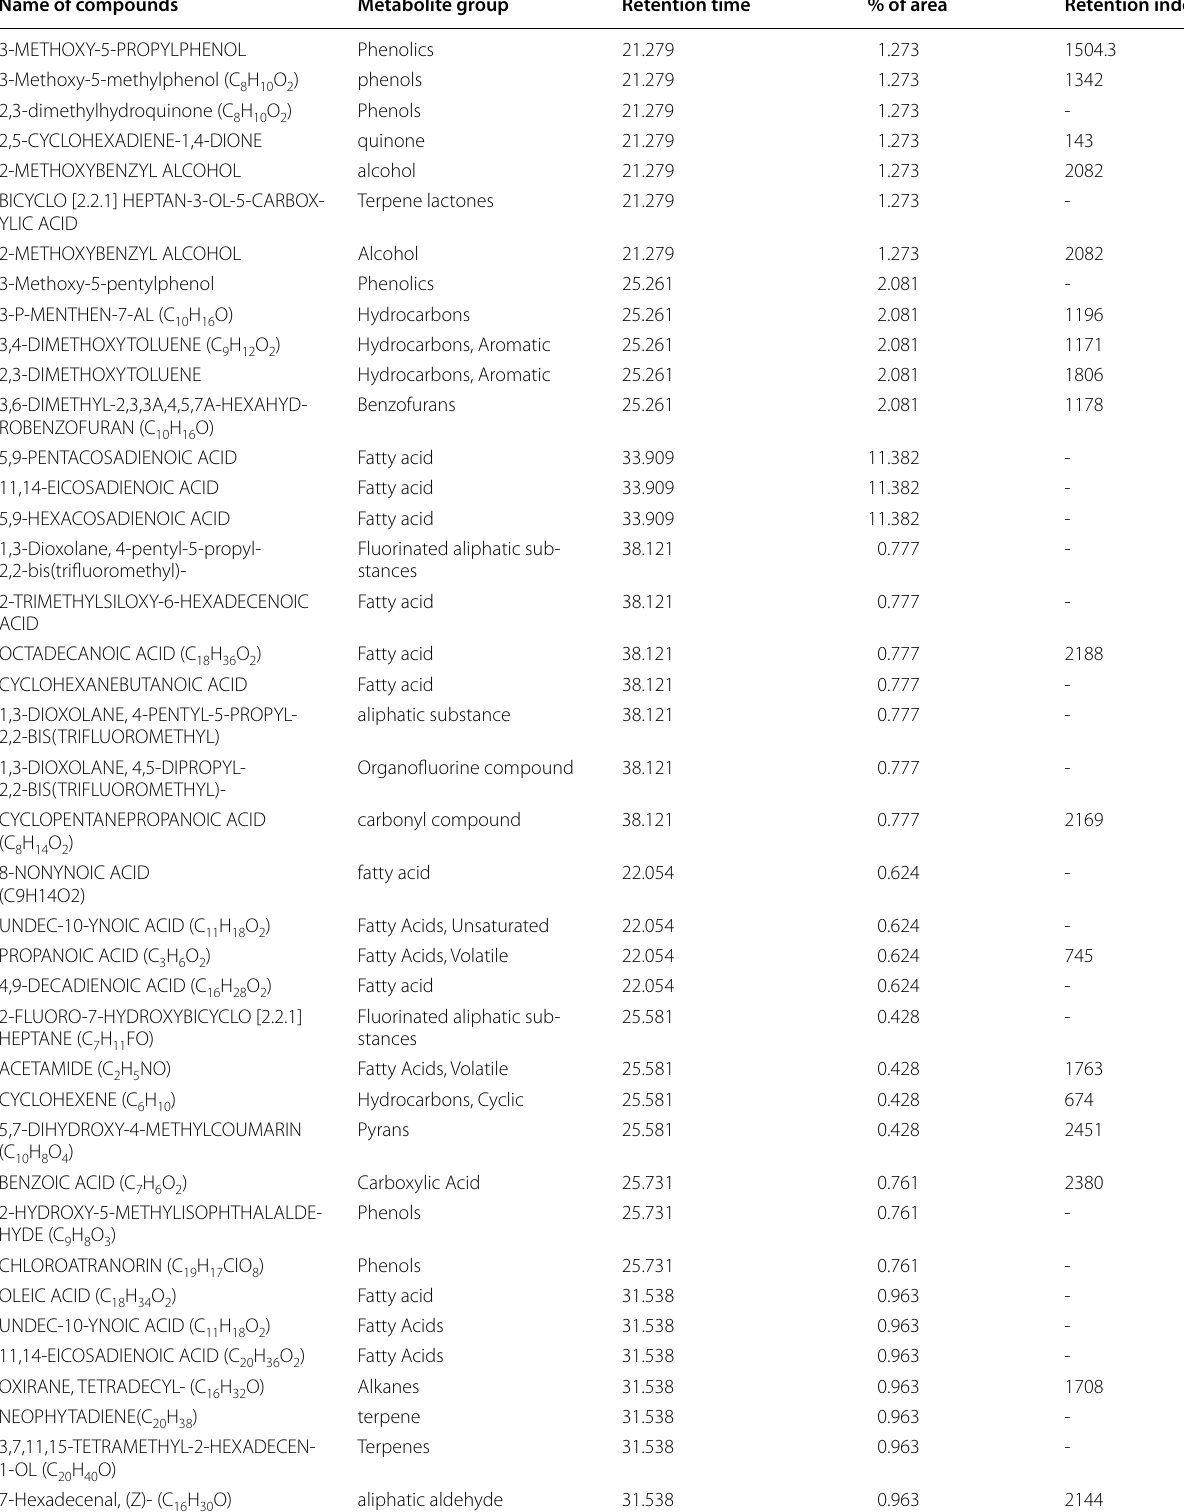
Table 8 Compound characterization through GC–MS analysis of T.